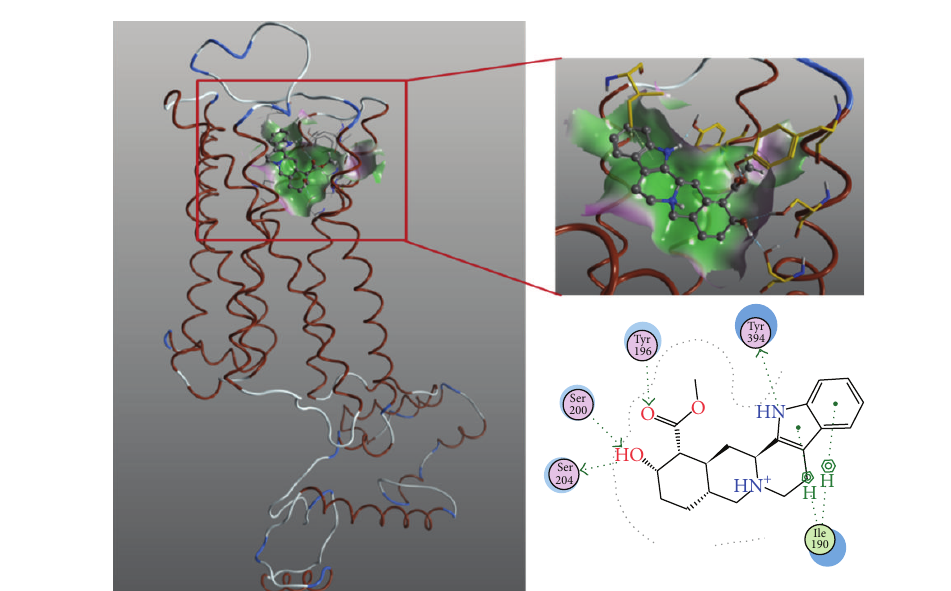
Figure 5: The binding mode of yohimbine with AR 𝛼